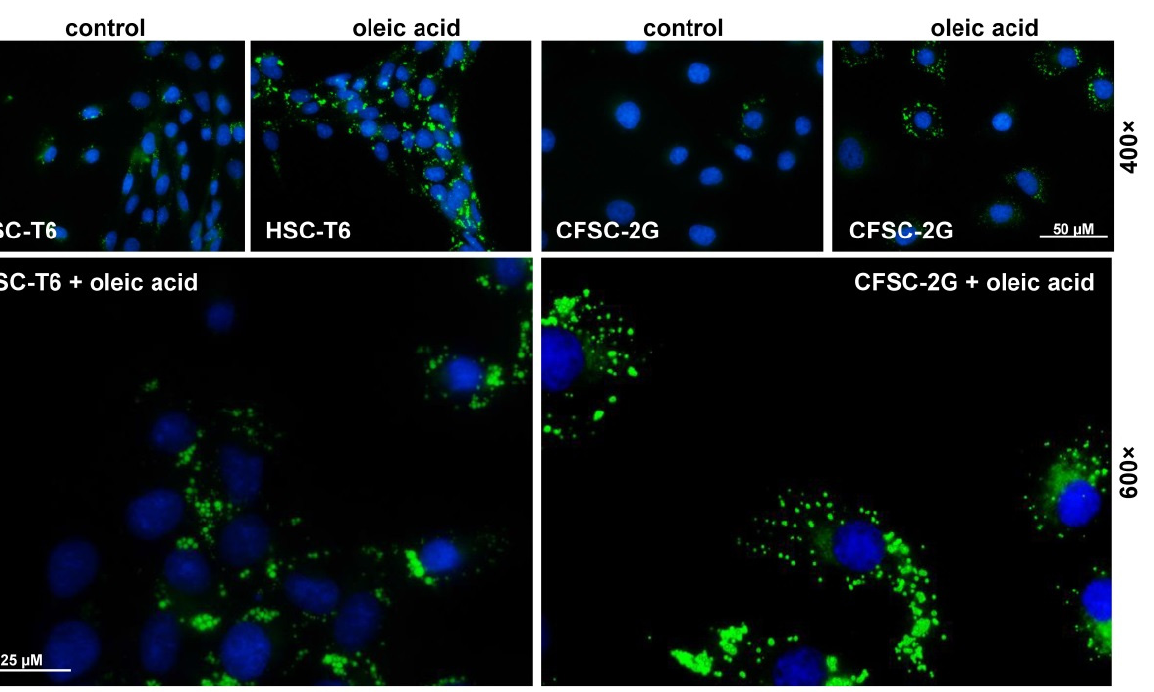
Figure 7. Lipid droplets in CFSC-2G. Cultured CFSC-2G cells were seeded on glass coverslips and grown in the presence of oleic acid and stained with BODIPY TM 493/503. Cells that were stimulated with the vehicle (i.e., phosphate-buffered saline solution) served as controls. In addition, the same set of stimulation was performed in rat HSC line HSC-T6, which is an established immortalized HSC model for hepatic lipid and retinoid metabolism [10]. Nuclei were counterstained with 4 ′ ,6-diamidino-2-phenylindole (DAPI), glass coverslips mounted, and picture taken under a fluorescence microscope at magnification 400× or 600×.